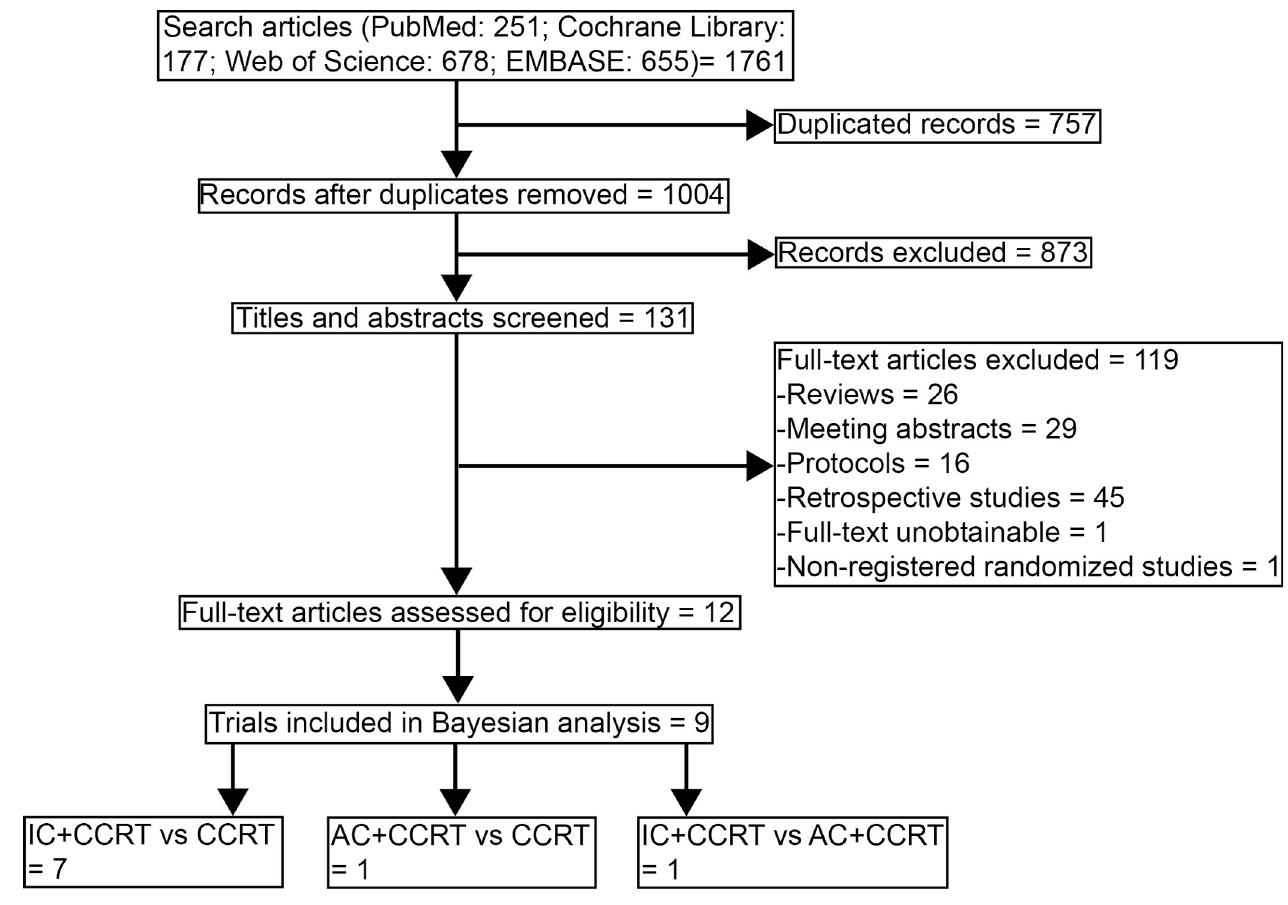
Fig 1. Flowchart of literature search and